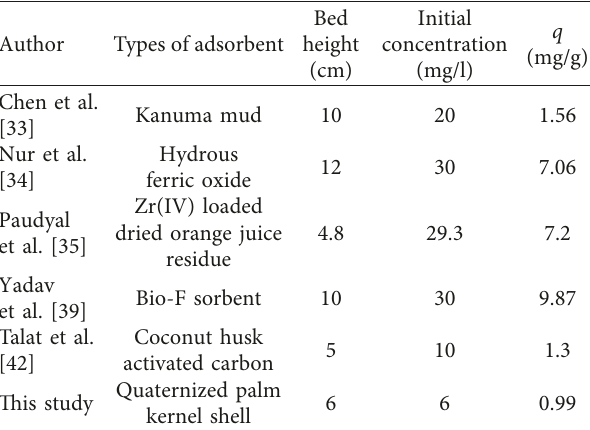
Table 10: Comparison of adsorption capacity by different ad- sorbents on fluoride